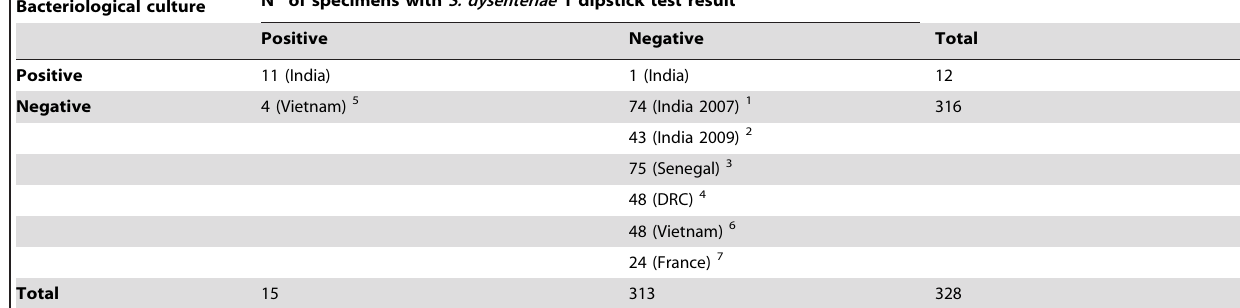
Table 2. Detection of S. dysenteriae 1 in 328 stool samples by RDSd1 test versus conventional culture.